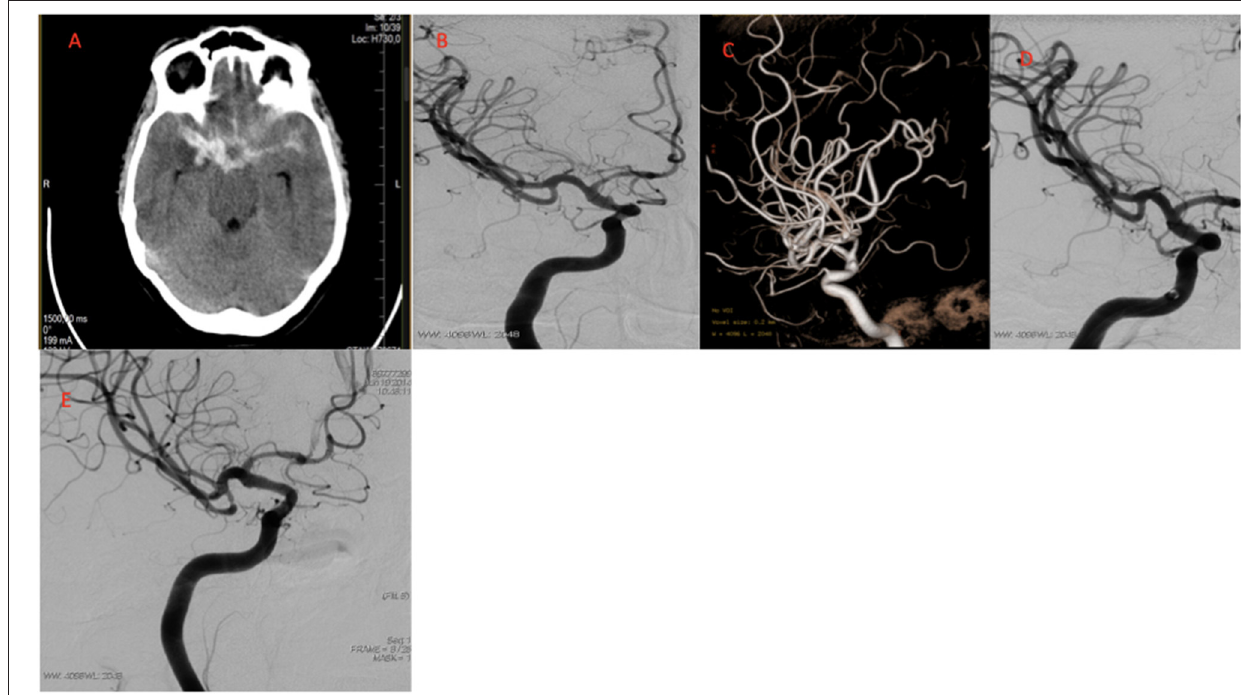
FIGURE 1 | Images of a typical case. (A) CT images after headache showing SAH Fisher CT grade 3. (B) Conventional DSA obtained before treatment showing supraclinoid ICA BBA. (C) 3D angiogram of BBA. (D) Immediate control angiogram OKM C type anurysm filling. (E) 3 month control angiogram OKM D type complete obliteration. CT, computed tomography; SAH, subarachnoid haemorrhage; DSA, Diagnostic cerebral angiography; BBA, Blood blister like aneurysm; OKM, O’Kell–Marotta grading scale.